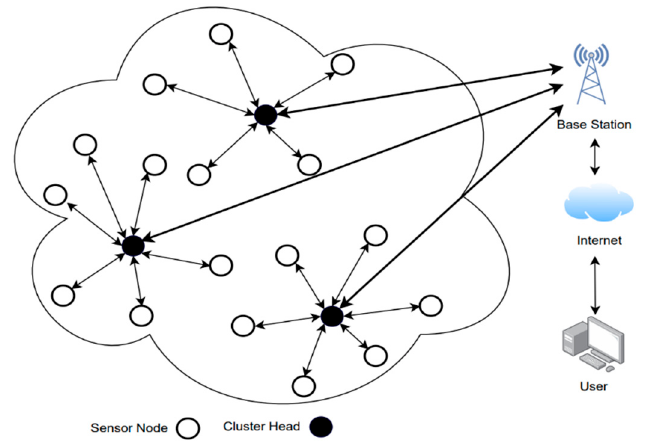
Figure 1. Typical hierarchical architecture.